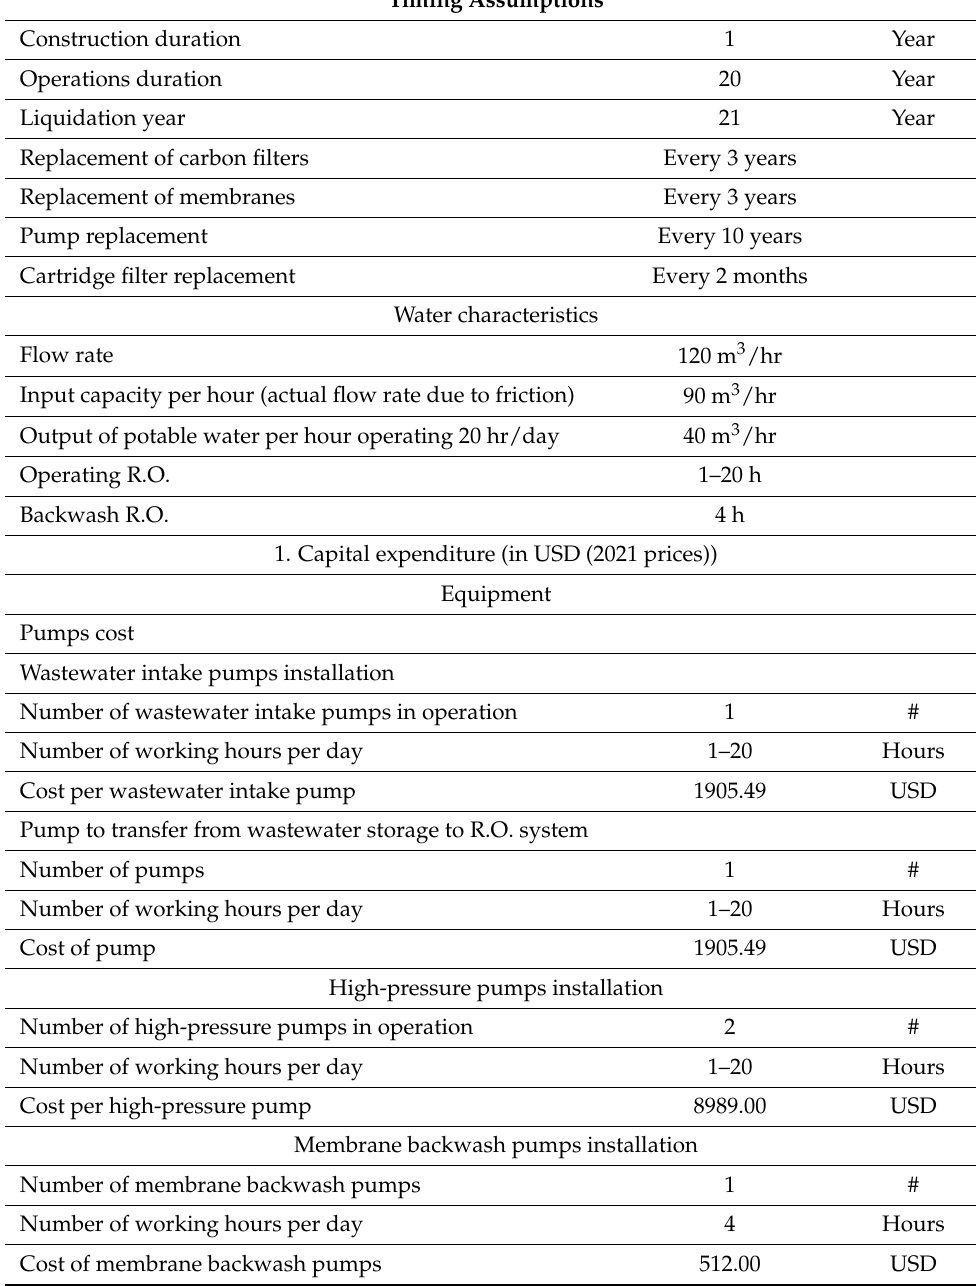
Table A1. Parameter Values Used in Modeling of Levent Wastewater RO